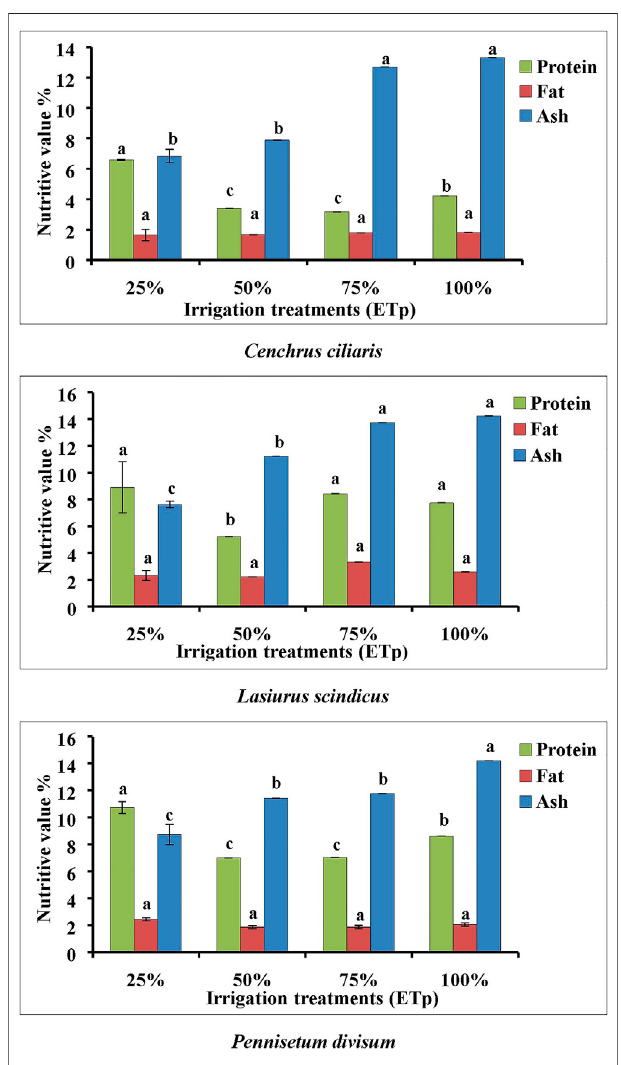
FIGURE6| Effectofdifferentirrigationregimesonmeanprotein,fat,and ash percentage of Cenchrus ciliaris , Lasiurus scindicus , and Pennisetum divisum . Bars labeled with different letters present signi fi cant difference at p < 0.001 and p < 0.05 between treatments. d. f = 16.